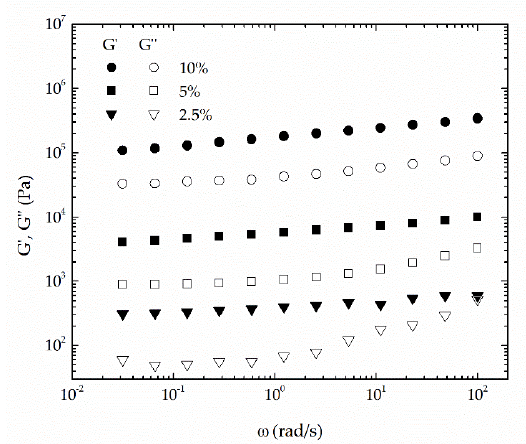
Figure 5. Evolution of the storage ( G ′ ) and loss ( G ″ ) moduli with frequency for epoxidized lignin-based oleogels prepared with sample EAL1 at different concentrations ( G ′, filled symbols; G ″ , empty symbols).